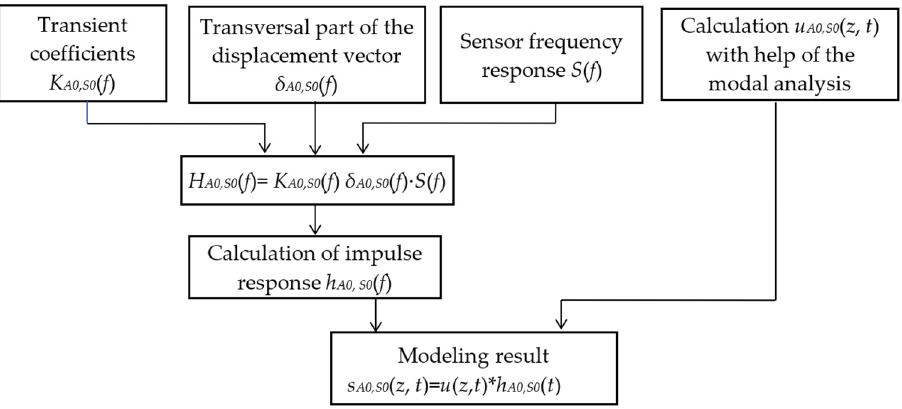
Figure 5. Flowchart of the algorithm for modeling the acoustic path.